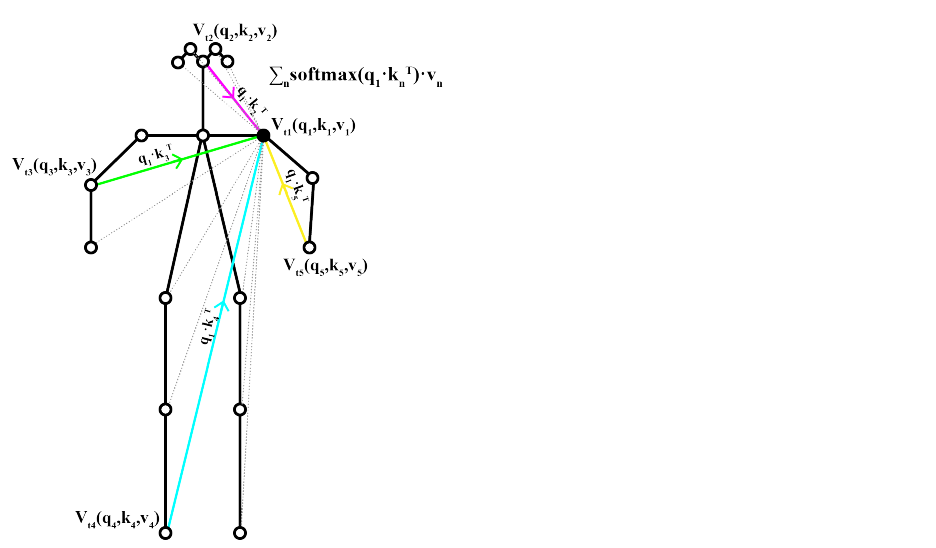
Figure 6. Illustration of Spatial Self-Attention (SAA). For ease of explanation, the process is only shown with a group of five joints as an example, but in fact it runs on all